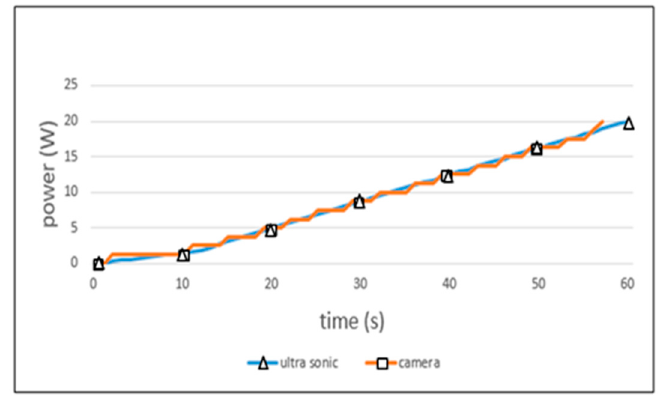
Figure 13. Power consumption of smart sensing period.